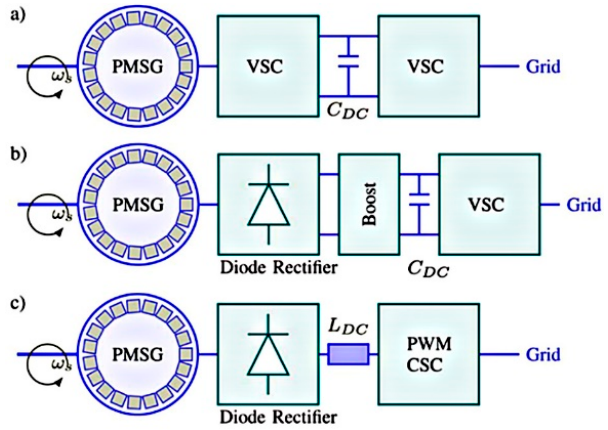
Figure 3. Three possible configurations for permanent magnet synchronous generators (PMSG) integration: ( a ) back-to-back converters with voltage source converters (VSCs). ( b ) Diode-bridge rectifier and boost converter. ( c ) pulse-width modulated-current source converter (PWM-CSC) [27]. Different to the VSC, the electrolytic capacitor is not needed in the PWM-CSC